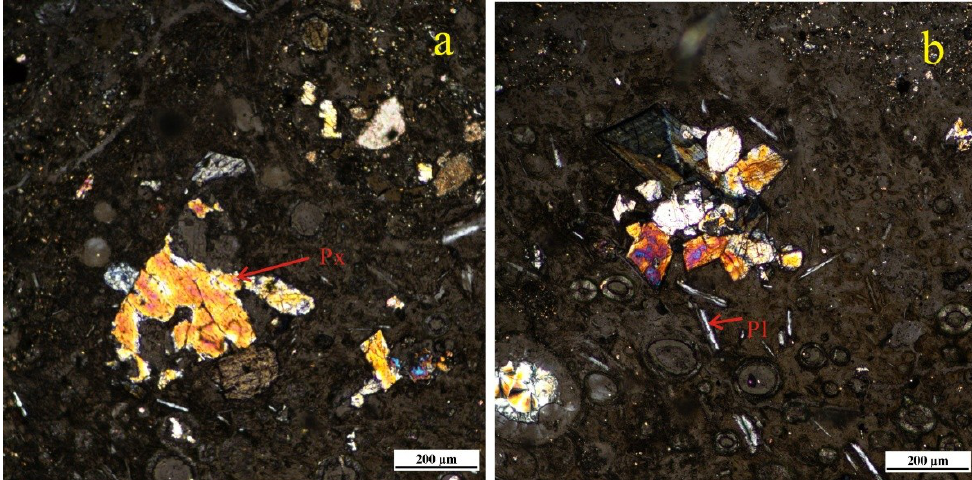
Figure 2. Photographs of the basaltic pyroclastic rocks under the microscope (cross polarized). Labels represent: Px-pyroxene; Pl: plagioclase. (a) pyroxene phenocryst in basaltic pyroclastic rocks; (b) amygdala in basaltic pyroclastic rocks